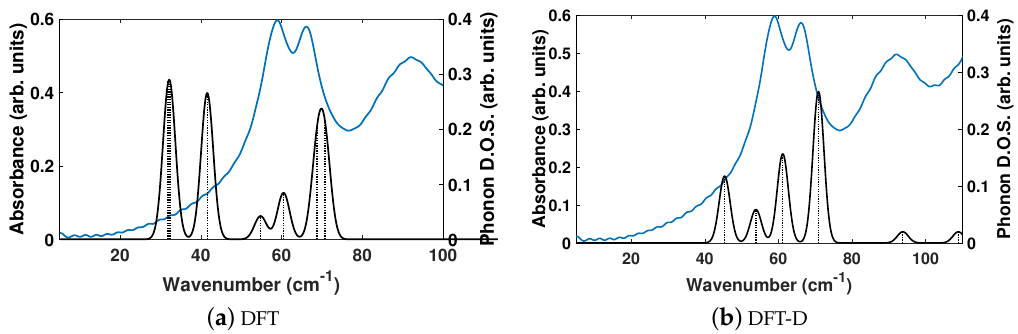
Figure 4. Same description as in Figure 2, but for 1,2-bis(4-pyridyl)ethane (BPEth).